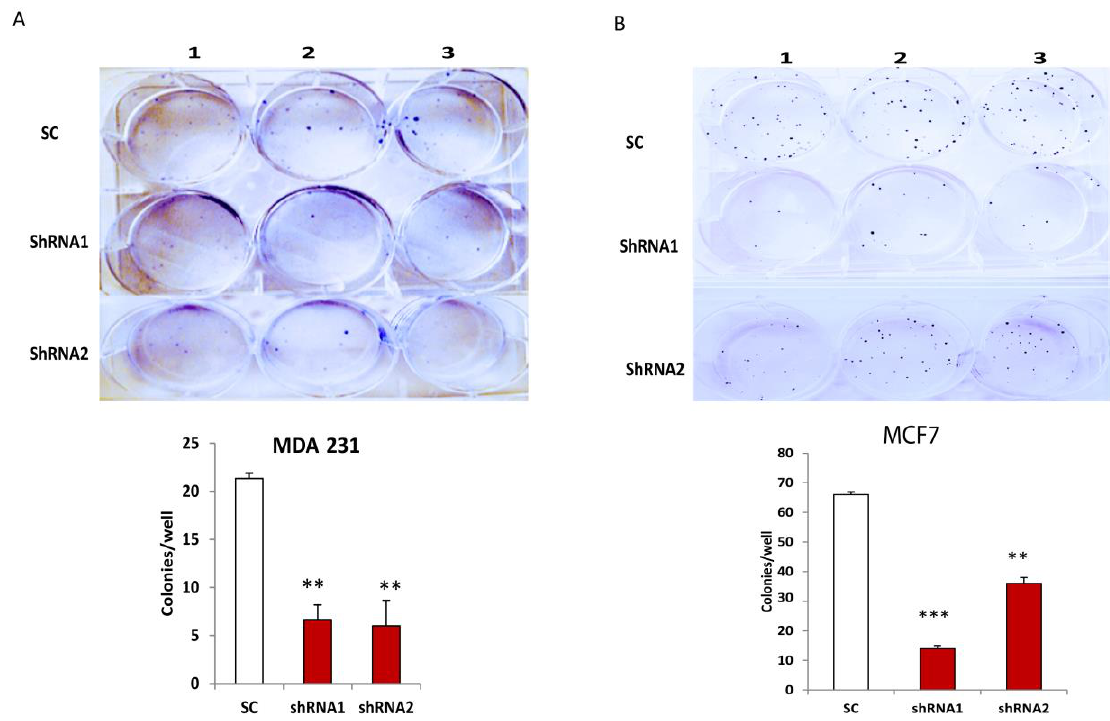
Figure 3. Silencing CLDN1 inhibits breast cancer cell survival. ( A , B ) Cell survival in MDA-MB-231 ( A ) and MCF7 ( B ) cells transduced with different CLDN1 lentiviral shRNAs and control vectors were examined by cell colony formation assays. Cell colonies were counted after culture (two weeks) in six-well plates and Crystal Violet staining. The number of colonies in CLDN1 lentiviral shRNA transduced cells was compared to that in control cells. Data were analyzed and presented from three independent experiments (** p < 0.01; *** p < 0.001).